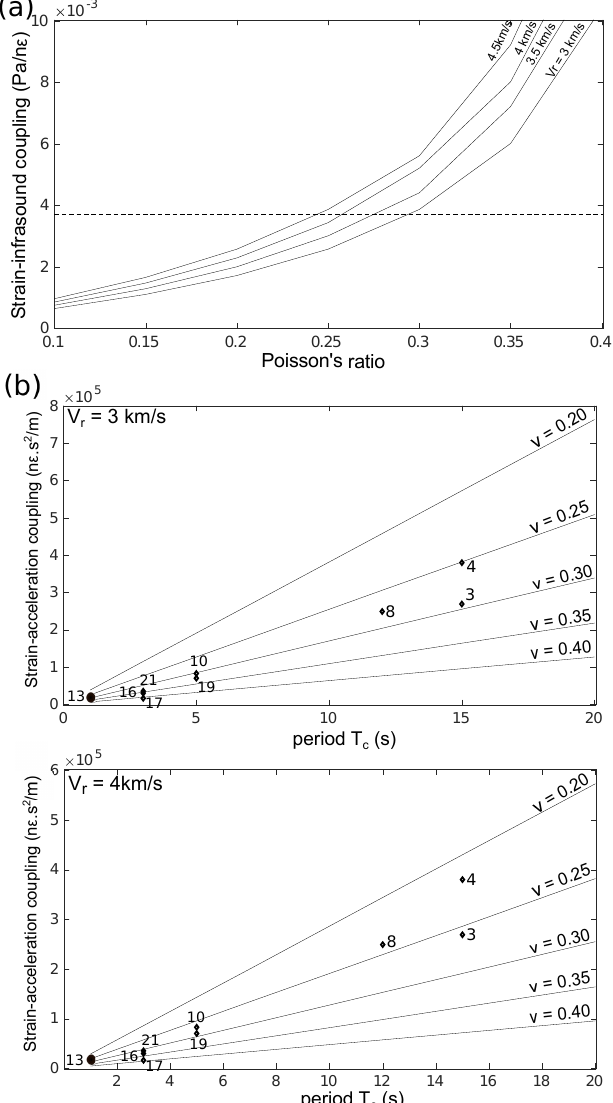
(cid:16) (cid:17)(cid:16) (cid:17) γ V r as a function of the 1 − 2 γ 0.24